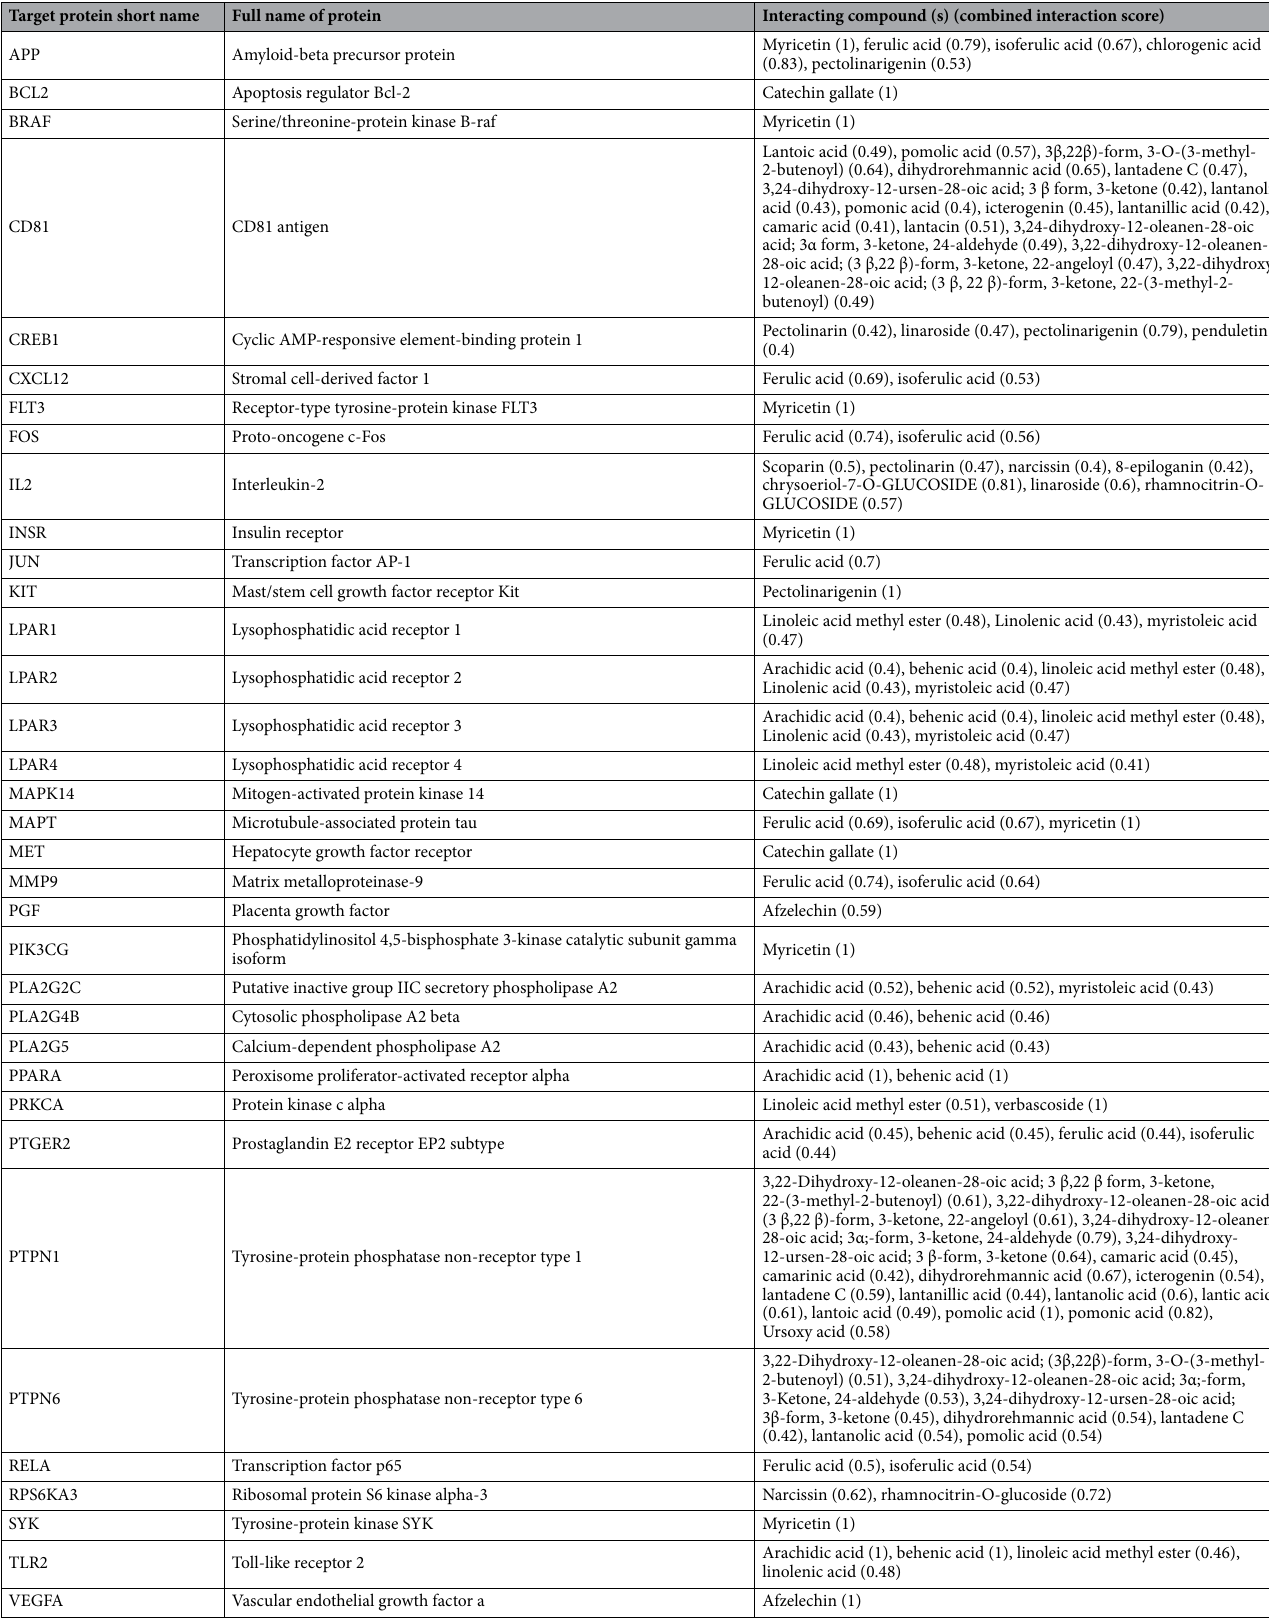
Table 2. Potential protein targets of L. camara